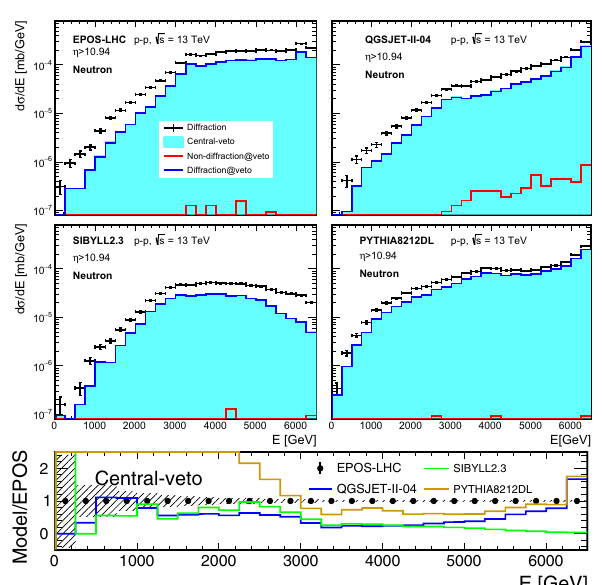
Fig. 7 Neutron spectra at η > 10 . 94 generated by EPOS-LHC, QGSJET-II-04, SYBILL 2.3, and PYTHIA 8212DL. The top four pan- els show the spectra of true diffraction ( black lines ) and diffractive- like events corresponding to central-veto selection ( filled gray areas ), which are defined as events without any P T > 100 MeV charged par- ticles at | η | < 2 . 5; in addition, the central-veto events were classified by nondiffraction ( red ) and diffraction ( blue ) again according to MC true information. The bottom plot shows the ratios of the central-veto spectrum of each model to the central-veto spectrum of EPOS-LHC